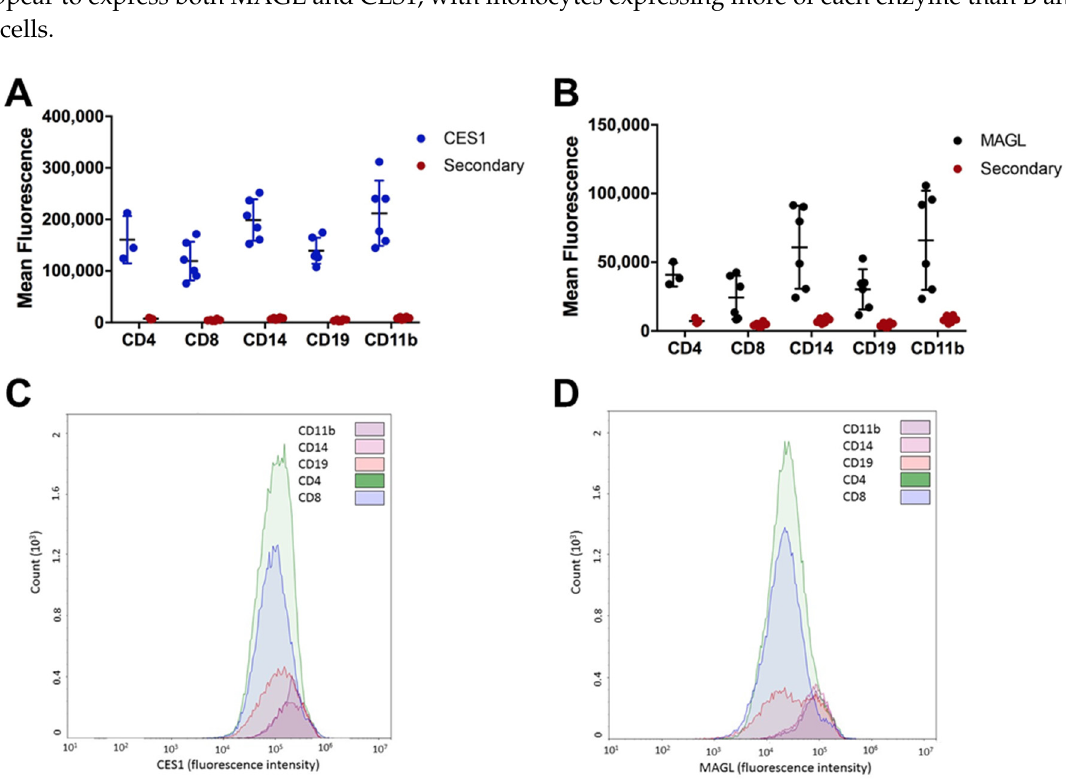
Figure 4. CES1 and MAGL are more highly expressed in monocytes than in lymphocytes. Commercially obtained PBMCs were stained extracellularly for various cell populations (monocytes, CD14 or CD11b), T cells (CD4 or CD8), and B cells (CD19)) and intracellularly for CES1 ( A , C ) or MAGL ( B , D ). Significantly more fluorescence was detected between the primary antibodies (CES1 or MAGL) than for the secondary antibody alone ( A , B ). p < 0.5 by two-way analysis of variance for all cell populations except MAGL intracellular staining of CD4 + T cells ( p = 0.1158), CD8 + T cells ( p = 0.2618), and CD19 + B cells ( p = 0.0723). Representative histograms from one donor are provided in ( C , D ).